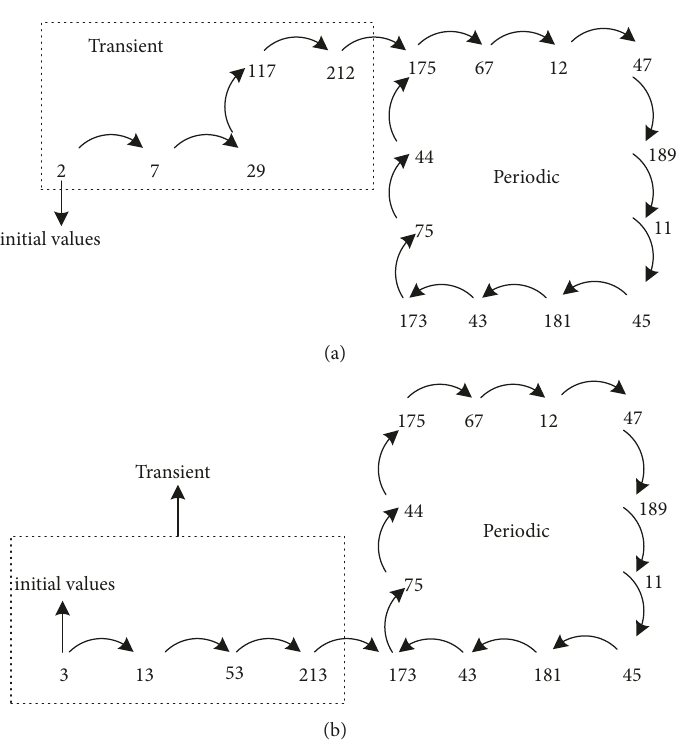
Figure 3: The illustration of iterations of the Tent mapping with different initial values. (a) 𝑧 1 = 2 ; (b) 𝑧 1 = 3 .